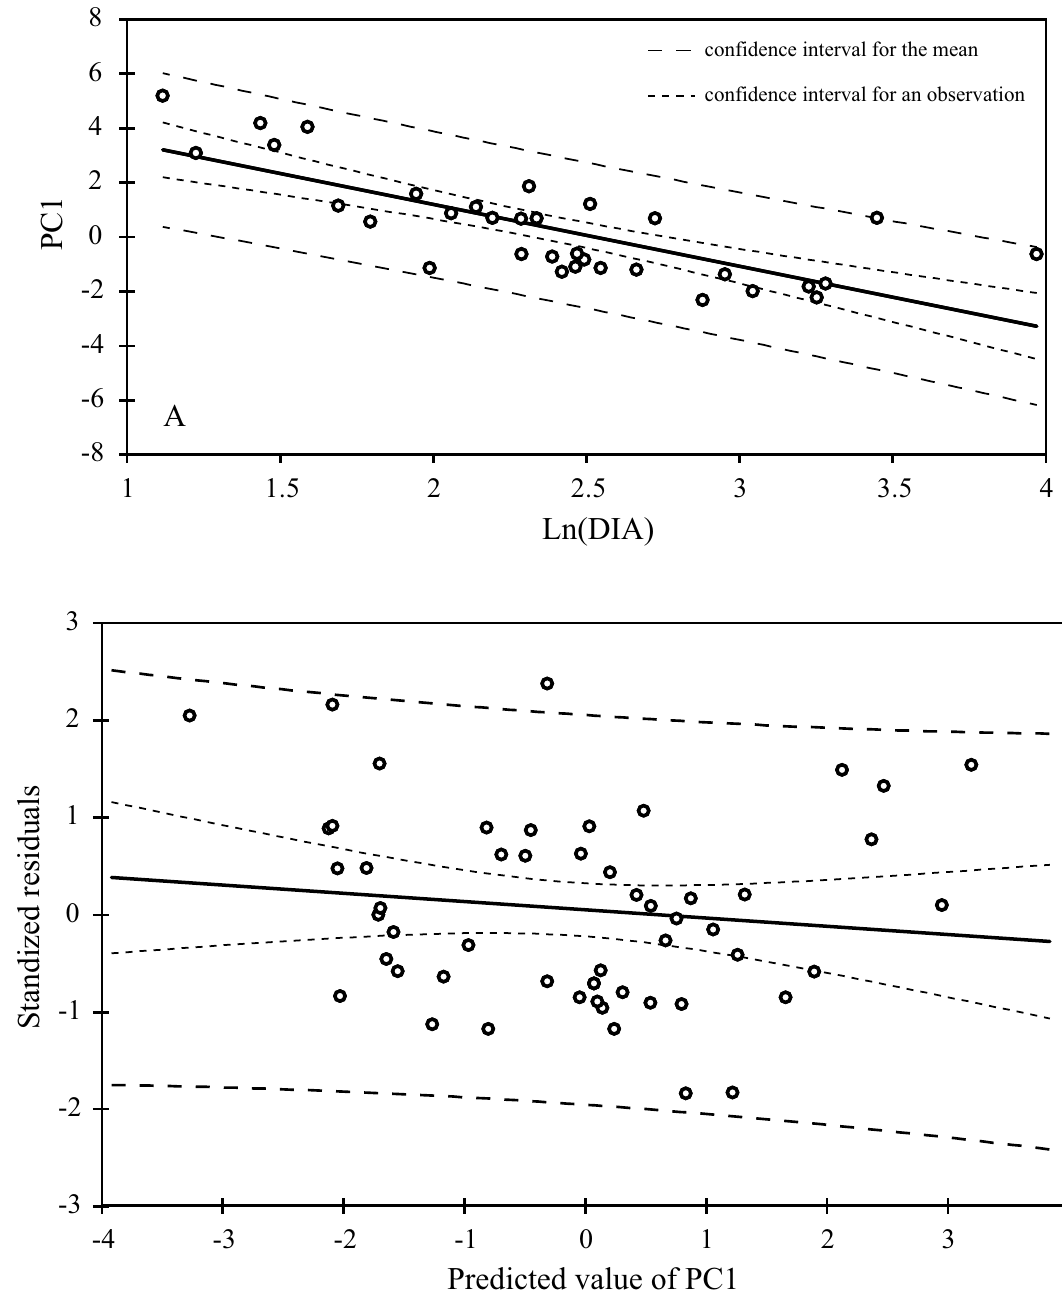
Figure 3. Linear regression model explaining the variation of PC1 according to the diameter of branch (caliber) (PC1 = f(Ln(DIA)) and diagram of the standardized residuals of the